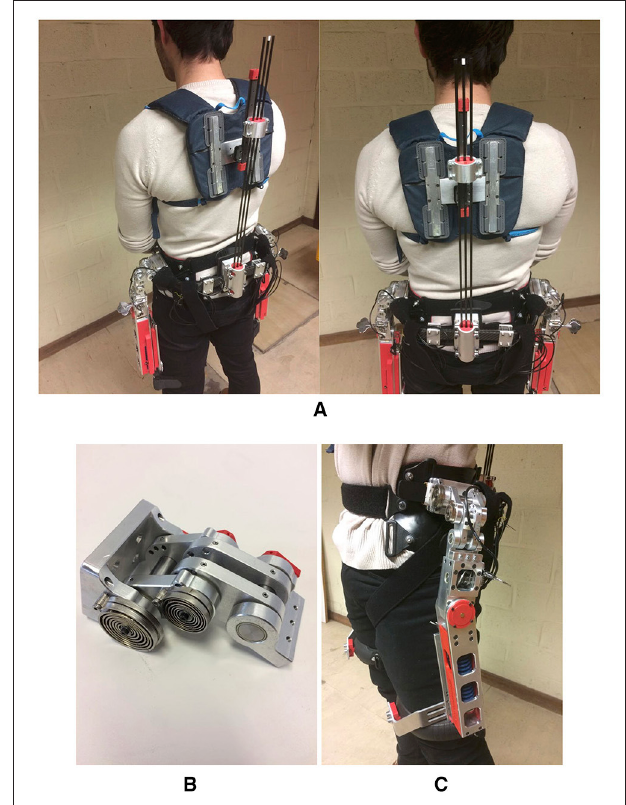
FIGURE 5 | Elastic spinal module (A) . Three carbon fiber beams ( D = 4 mm) provide the necessary flexibility to allow for the required range of motion, while providing a restoring torque when bent; Three parallel hinge joints (B) . This mechanism is on the one hand used to compensate for misalignment and on the other hand to provide a good fit. Torsional springs are mounted on the top two joints to avoid singularities and increase comfort; Misalignment compensation mechanism hip and torque source hip (C) . The torque, that is generated by the actuator is transmitted through the misalignment compensation